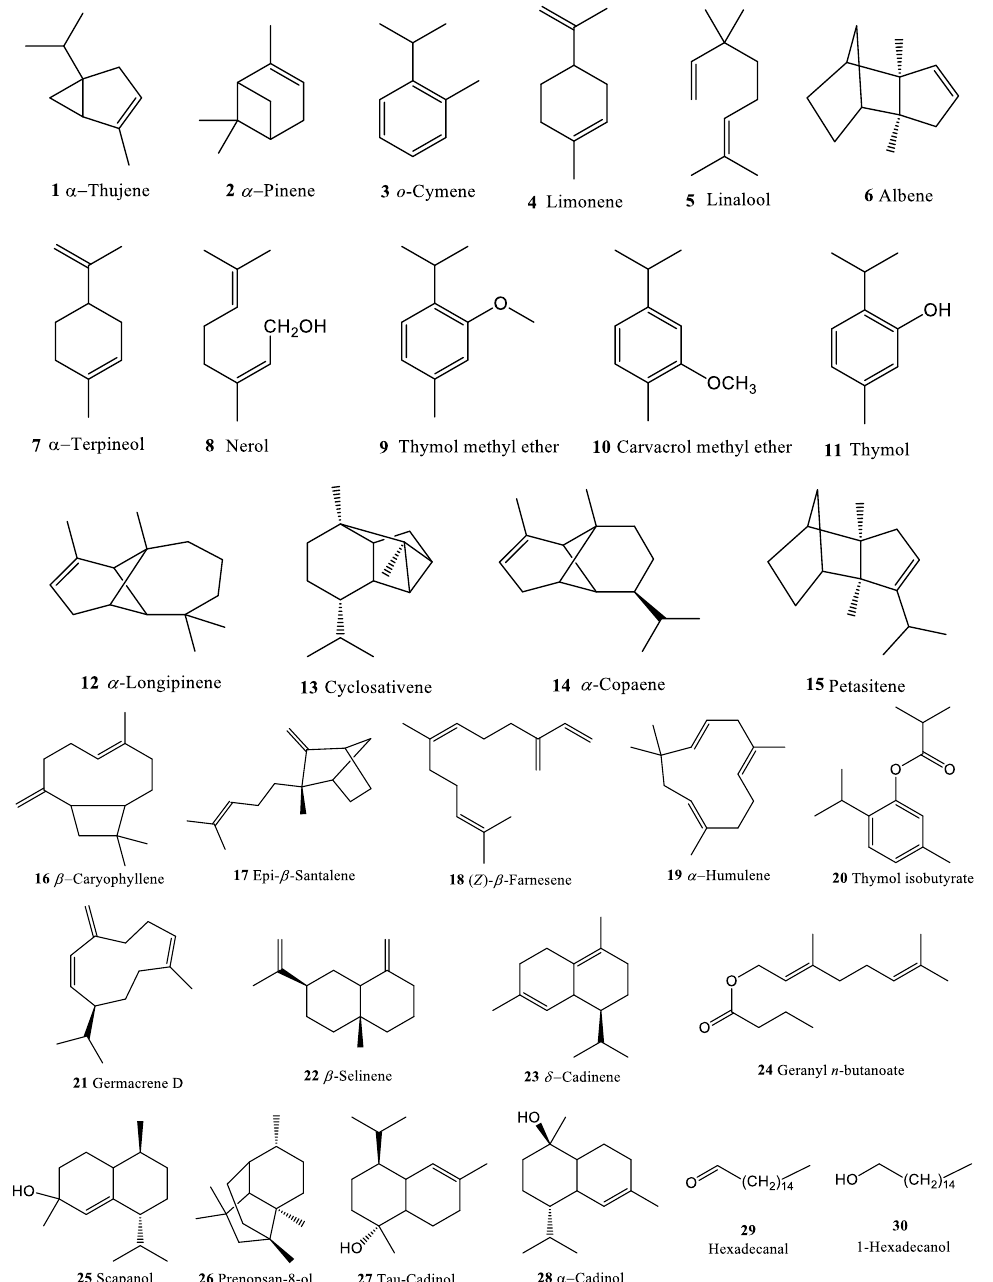
Figure 1. Chemical structure of the volatile compounds ( 1 − 30 ) identified from total essential oils of B. lanceolaria.